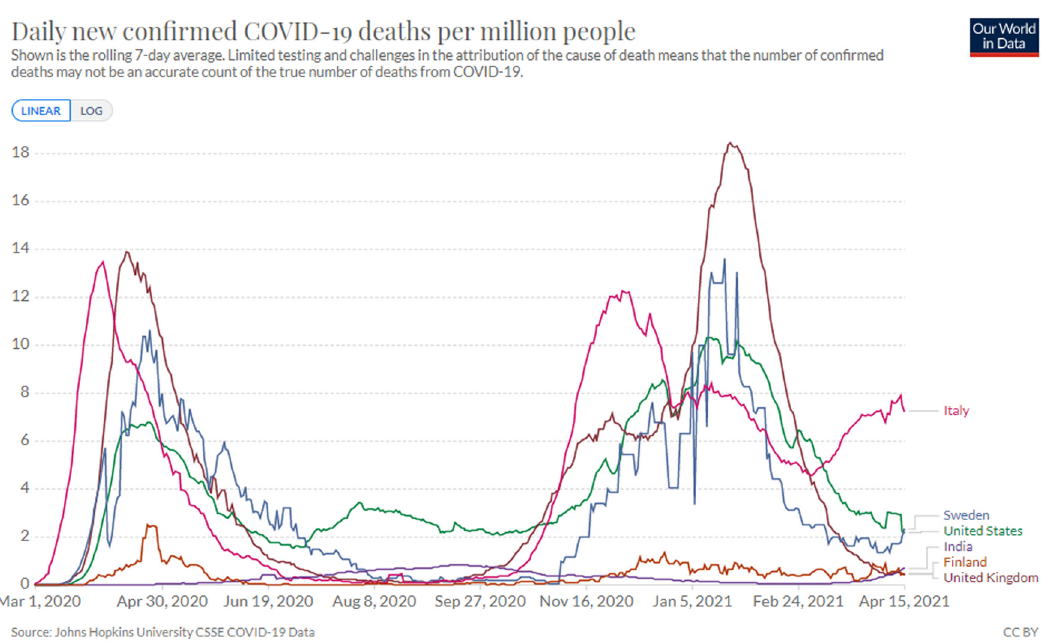
Figure 2: Daily new con fi rmed COVID - 19 deaths per million people, rolling 7 - day averages collected from ref. [ 13 ] for selected